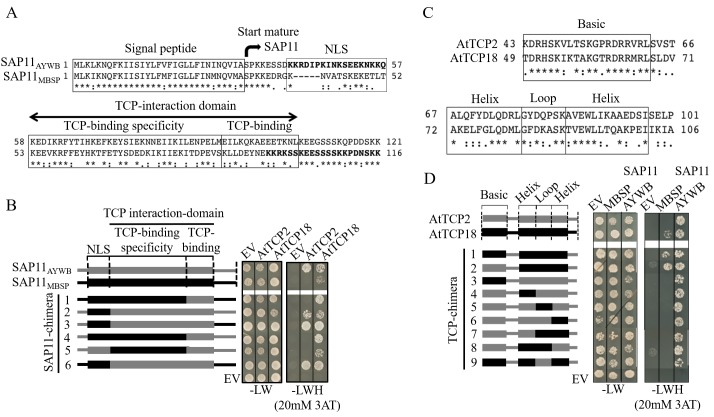
Characterization of domains involved in SAP11-TCP binding specificity.(A) SAP11AYWB and SAP11MBSP protein sequence alignment. Phytoplasmas secrete the mature protein, without signal peptide, into plants. The locations of the nuclear localization signal (NLS) in both proteins are indicated in bolt fonts. The regions corresponding to the SAP11AYWB NLS that is not conserved in SAP11MBSP within the rectangle are used for generating the chimeras in Fig 2B. The locations of regions within the TCP-interaction domains to generate the chimeras illustrated in Fig 2B are indicated with a double-sided arrow and within rectangles. (B) Yeast two-hybrid assays showing that the TCP-interaction domain determines binding specificity of SAP11 proteins to AtTCP2 (class II CIN-TCP) and BRC1 (AtTCP18) (BRC1, class II CYC/TB1 TCP). Domains identified in the SAP11 proteins and used for generating the chimeras correspond to those of Fig 2A. Abbreviations: EV, Empty vector control; -LW, media composition that enables yeast to grow when SAP11 and TCP plasmids are present; -LWH (20 mM 3-Amino-1,2,4-triazole (3AT)), selection medium that shows growth of yeast colonies when SAP11 and TCP interact. (C) Aligned amino acid sequences of the TCP domains of AtTCP2 and BRC1 (AtTCP18). Regions identified within the basic and helix-loop-helix domain are boxed and correspond to schematic illustrations of chimeras shown in Fig 2D. (D) Yeast two-hybrid assays showing that the binding specificity of SAP11MBSP requires the complete BRC1 (AtTCP18) helix-loop-helix domain. Domains identified in the TCP proteins correspond to those of Fig 2C. Abbreviations: see legend for Fig 2B above.